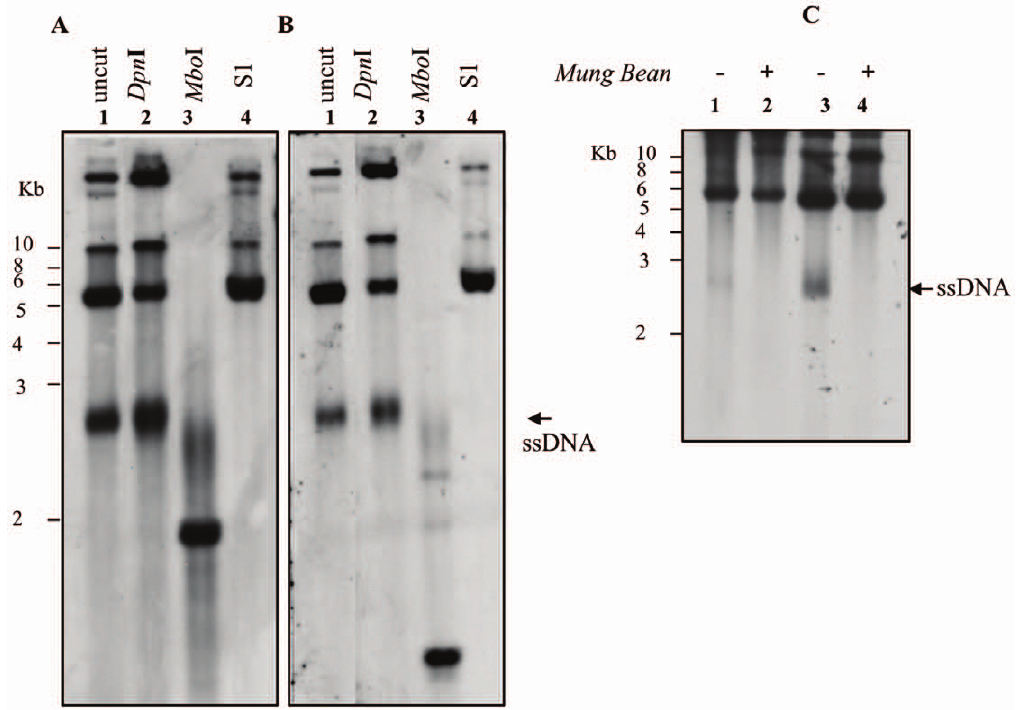
Figure 5. S1 and MungBean nuclease sensitivity. (A, B) Low M r DNA from a URA3 + LEU2 + clone derived from co-transformation of pAAVRepURA with plasmid pG.Rep68, was digested with Dpn I (loaded in the lane 2), Mbo I (loaded in the lane 3) , S1 nuclease (in the lane 4) and was analyzed on Southern Blot using URA3 probe (A) or ITR probe (B). (C) Southern blot analysis of low M r of two URA3 + LEU2 + clone derived from co-transformation of pAAVRepURA with plasmid pG.Rep68 was digested with Mung Bean nuclease (in the lane lane 2 and 4) and compared with the not digested DNA (lane 1, 3). DNA was detected using the URA3 probe. The arrows indicate the ssDNA which disappeared after digestion with S1 and Mung Bean